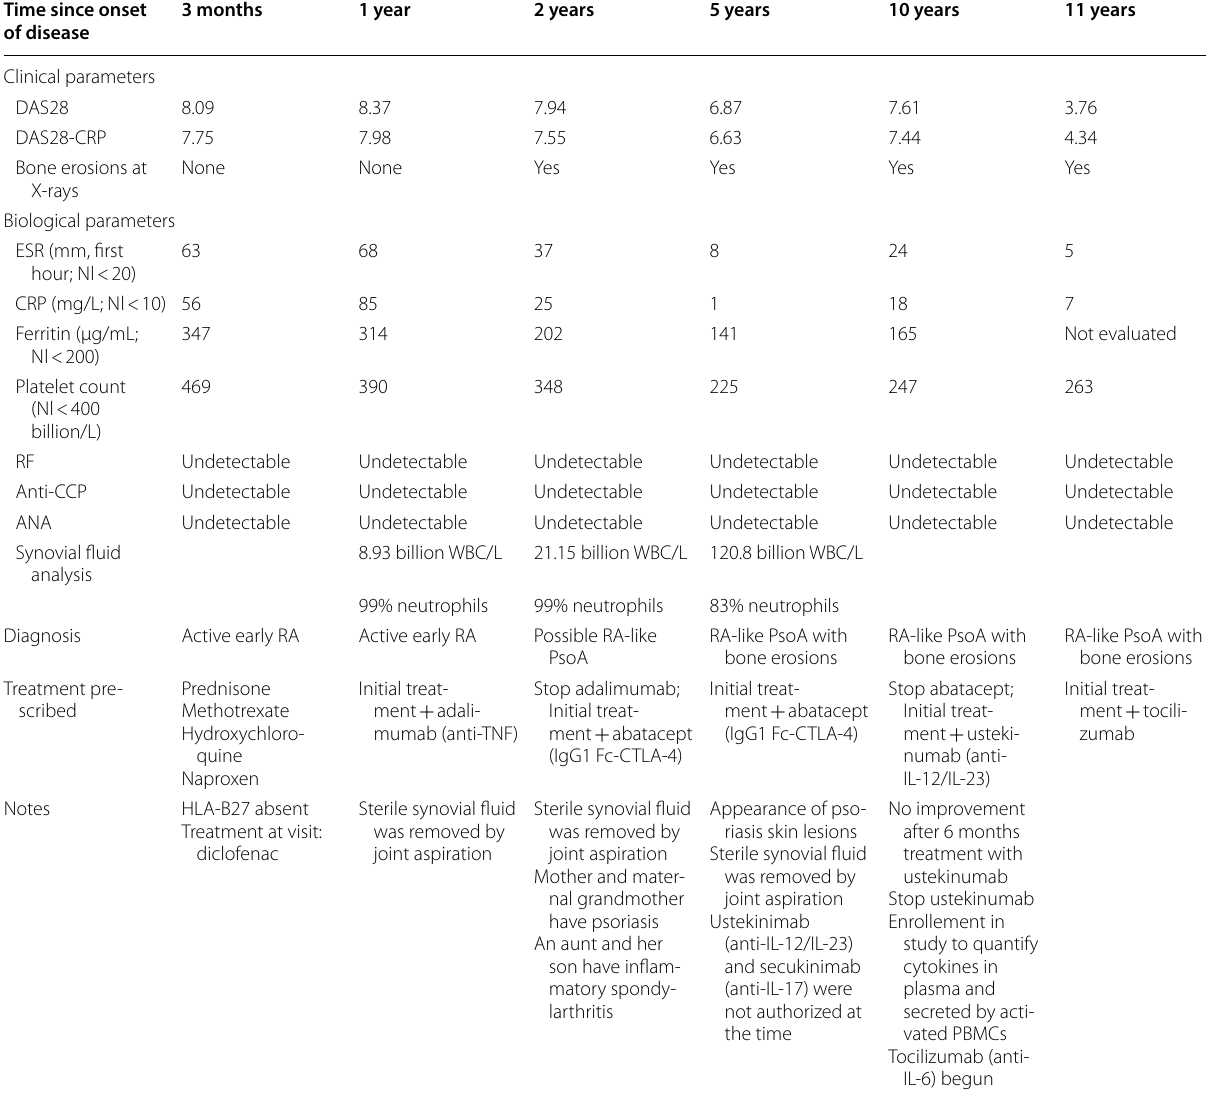
ANA antinuclear antibody, anti-CCP anti-cyclic citrullinated peptide, CRP C-reactive protein, DAS28 disease activity score of 28 joints, ESR erythrocyte sedimentation rate, Nl normal level, PsoA psoriatic arthritis, RA rheumatoid arthritis, RF rheumatoid factor, WBC white blood cells